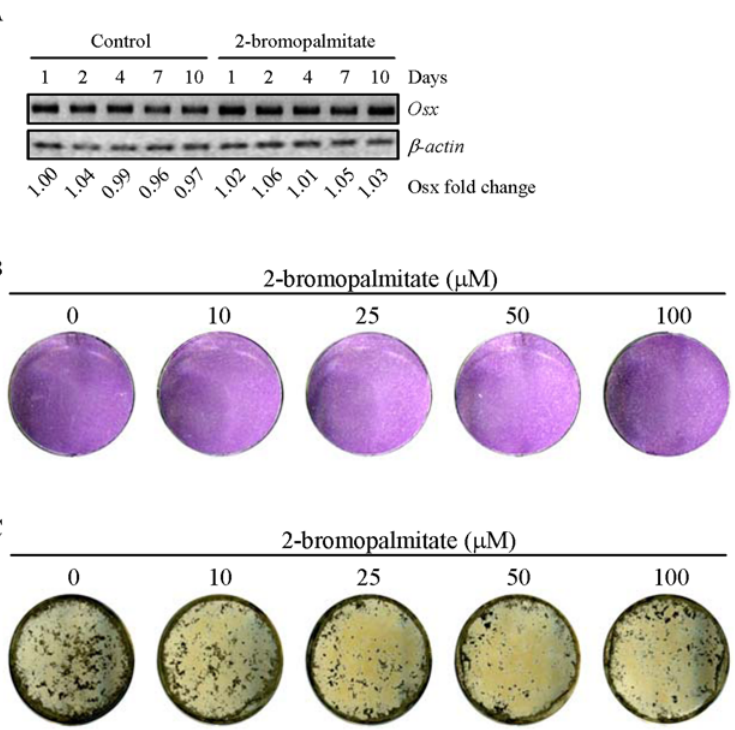
Figure 5. Overexpression of Osx in p53 2 / 2 osteoblasts rendered resistance to the inhibitory effect of 2BP on differentiation. A. 2BP treatment did not significantly down-regulate the mRNA levels of Osx. Primary osteoblasts were cultured in the presence or absence of 2BP for different periods of time and total RNA was isolated and RT-PCR was carried out to determine the mRNA levels of Osx. The value of control (lane 1) was set at 1.00. B. PAT inhibitor did not markedly affect ALP staining in p53 2 / 2 osteoblasts. p53 2 / 2 osteoblasts were treated with different amounts of 2BP for 7 days and then stained for ALP. C. PAT inhibitor did not markedly affect bone nodule formation in p53 2 / 2 osteoblasts. p53 2 / 2 osteoblasts were treated with different amounts of 2BP for 21 days and then stained for